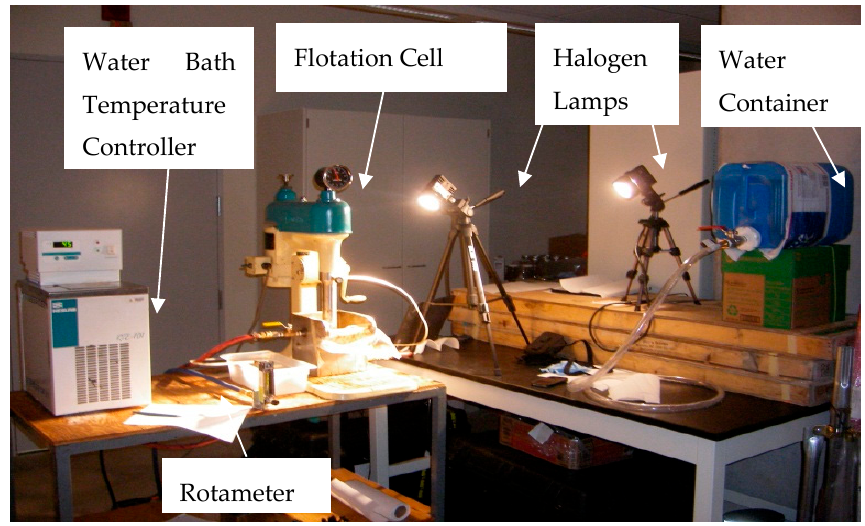
Figure 1. Flotation experimental apparatus.